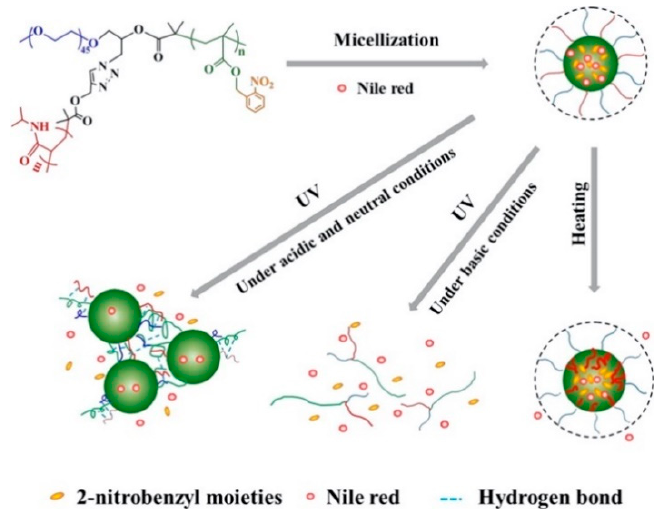
Figure 11. Self-assembly and dual UV/temperature response of PEG-PNBM-PNIPAM miktoarm star Figure 10. Self-assembly and dual UV / temperature response of PEG-PNBM-PNIPAM miktoarm star polymers. Reprinted with permission from reference [66] . Copyright 2017 Elsevier. polymers. Reprinted with permission from reference [66]. Copyright 2017 Elsevier.